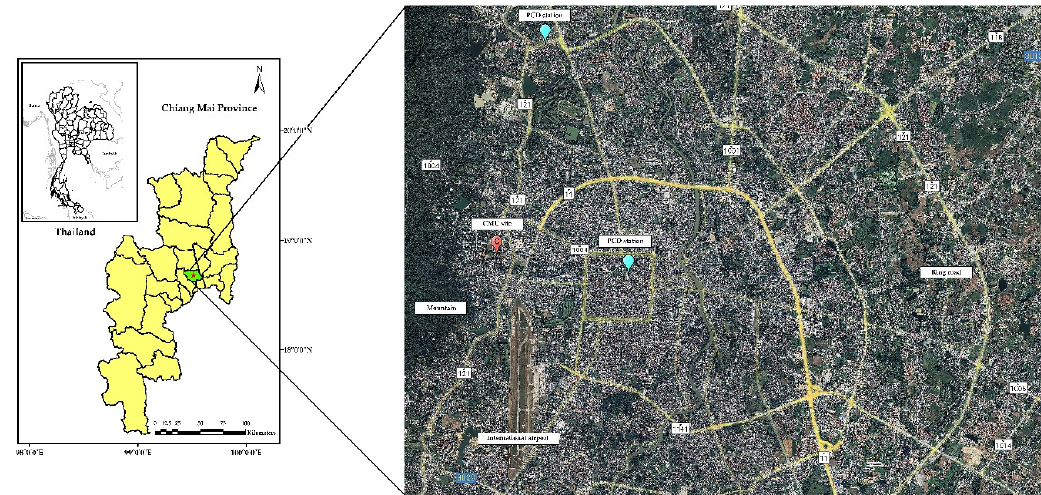
Figure 1. The location of the sampling site in Chiang Mai city.